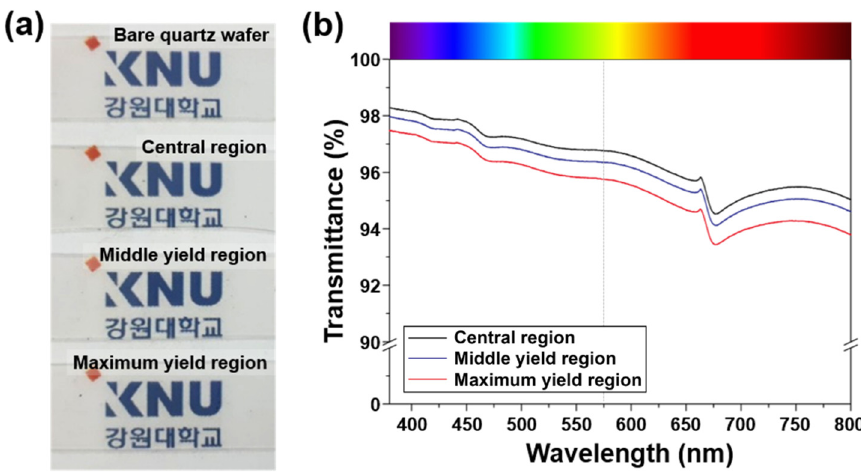
Figure 9. ( a ) Digital photo showing the different transmittances of SWNTs on quartz wafers. ( b ) UV-vis spectra recorded for a ST-cut quartz wafer in different synthesis yield regions.